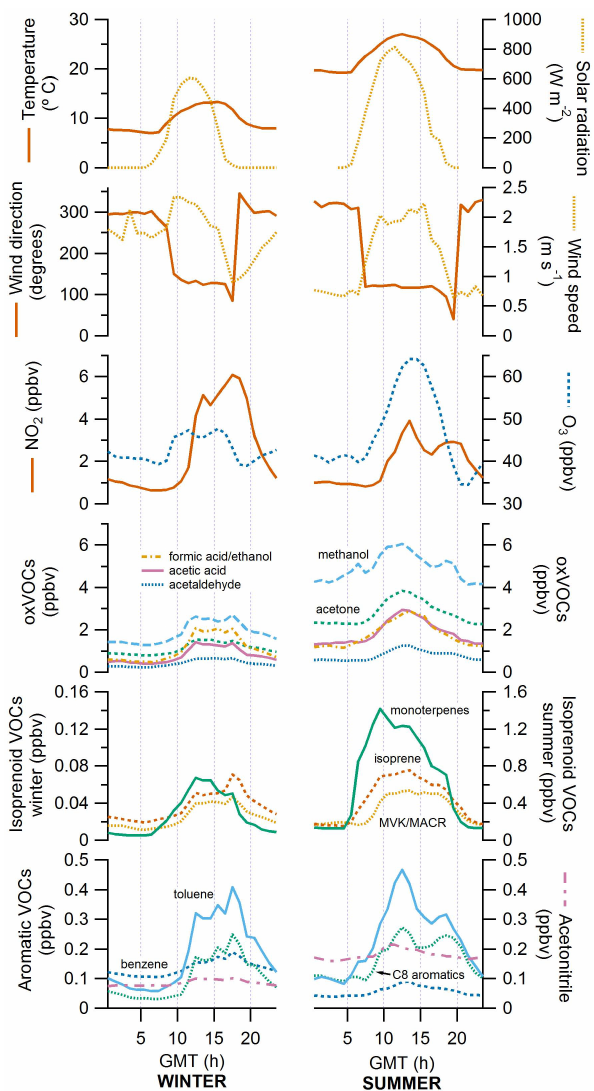
Fig. 8. Mean daily cycles of the majority of the variables stud- ied, comparing winter (left) with summer (right). VOC mixing ra- tios are split into three separate panels, corresponding to Figs. 5, 6, and 7: (i) one for short-chain oxVOCs: methanol, acetone, formic acid/ethanol, acetic acid and acetaldehyde; (ii) the second one for isoprenoid VOCs: monoterpenes, and isoprene and its degradation products MVK/MACR; (iii) the last panel for acetonitrile and aro- matic VOCs: benzene, toluene, and C8-aromatics. Note the differ- ent scaling for the isoprenoid VOCs between winter and summer (one order of magnitude higher in